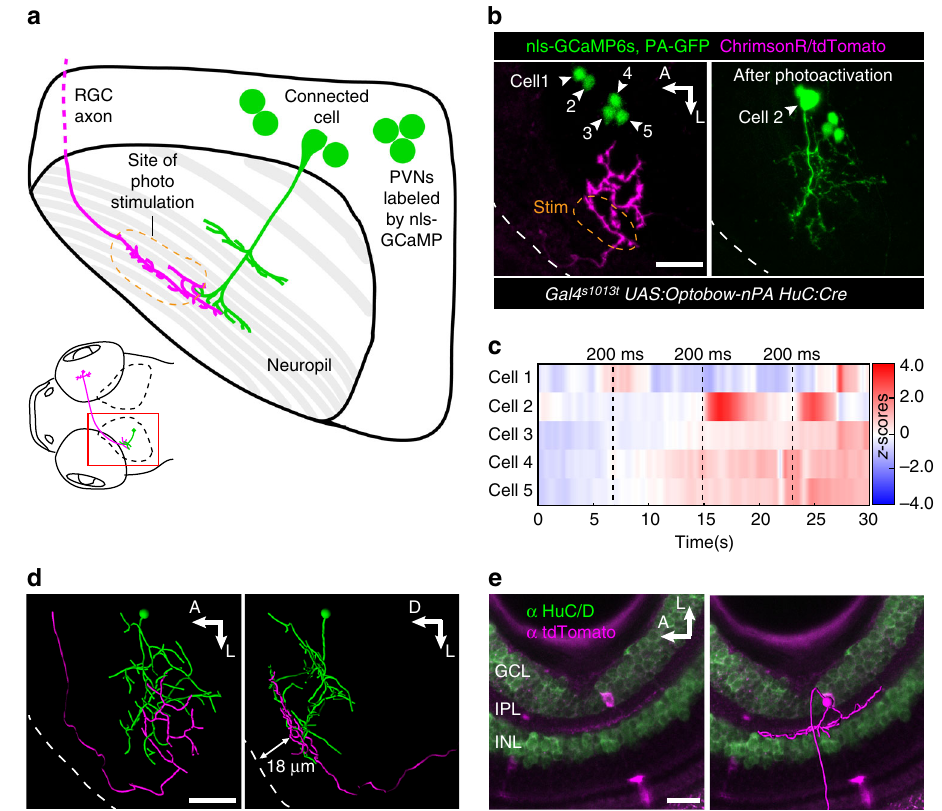
Fig. 6 Optobow analysis can be expanded to study long-range connectivity of different cell types. a Sketch simplifying the connection of an RGC axon with a PVN in the optic tectum. b Live expression of Optobow-nPA. A single RGC axon ( magenta ) and fi ve PVN nuclei are labeled ( green , left ). White dashed lines mark the skin. Upon identi fi cation of the connected cell#2, PA-GFP was photoactivated ( right ). Scale bar, 20 µ m. c Calcium traces ( Z -scores) for the cells annotated in b . Photostimulation epochs of 200 ms are indicated by dashed lines . Only cell#2 showed responses upon photostimulation. d Filament reconstructions in dorsal view ( left ) and transverse view ( right ). The RGC axon terminates in the stratum fi brosum et griseum super fi ciale (SFGS) layer 1 (18 – 20 µ m distance from skin), where it contacts the dendrites of the bistrati fi ed PVIN (cell#2). Scale bar, 20 µ m. e Immunostainings against HuC/D ( green ) and tdTomato ( magenta ) reveal the dendritic pattern of the activated RGC in the retina. A fi lament reconstruction is shown on the right . Its monostrati fi ed dendrites exclusively target the OFF layer of the IPL. Scale bar, 20 µ m. GCL, ganglion cell layer; INL, inner nuclear layer; IPL, inner plexiform layer; PVIN, periventricular